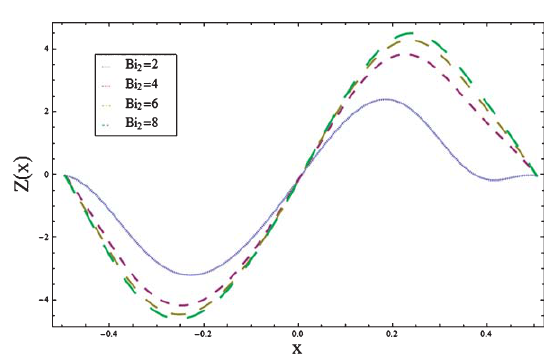
Fig. 14. Plot showing Z ( x ) versus x . Here a = 0 . 3, b = 0 . 5, d = 1, φ = π/ 4, (cid:14) = 1 . 5, Br = 2, Bi = 10, n = 0 . 398 and We = 0 . 1